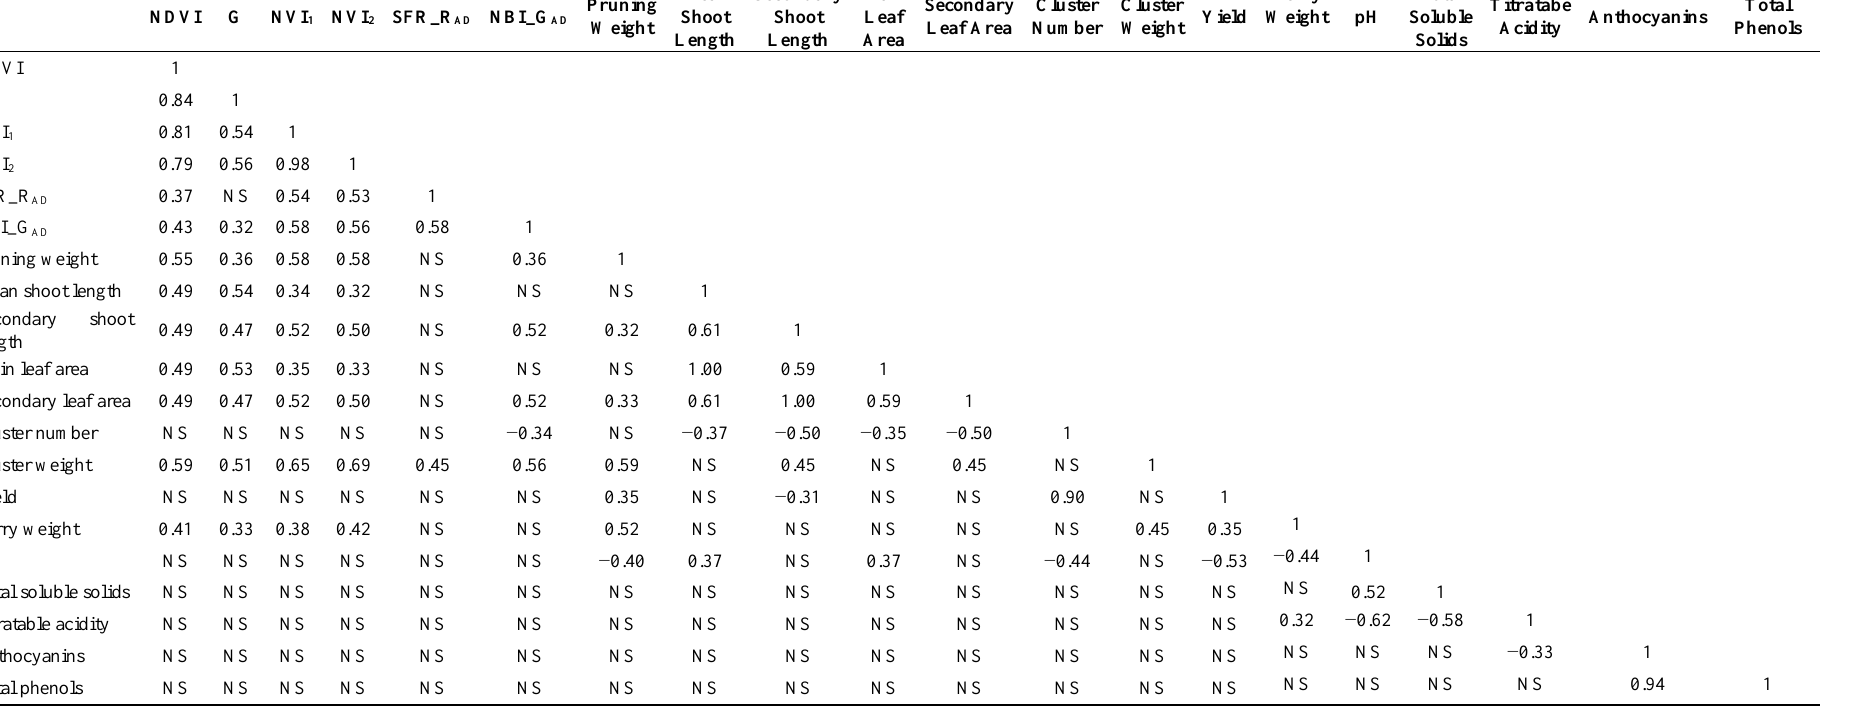
Table 3. Pearson correlation coefficients (for p -value < 0.01) for vegetative parameters (pruning weight, main shoot length, secondary shoot length, main leaf area per shoot, secondary leaf area per shoot, nitrogen status –NBI_G AD -, and chlorophyll content in leaves –SFR_R AD -), yield parameters (cluster number per vine, cluster weight, yield per vine, and berry weight) and grape composition variables (pH, total soluble solids, titratable acidity, anthocyanins, and total phenols) with spectral indices (NDVI, G, NVI 1 , and NVI 2 ) in a Tempranillo ( Vitis vinifera L.) vineyard.